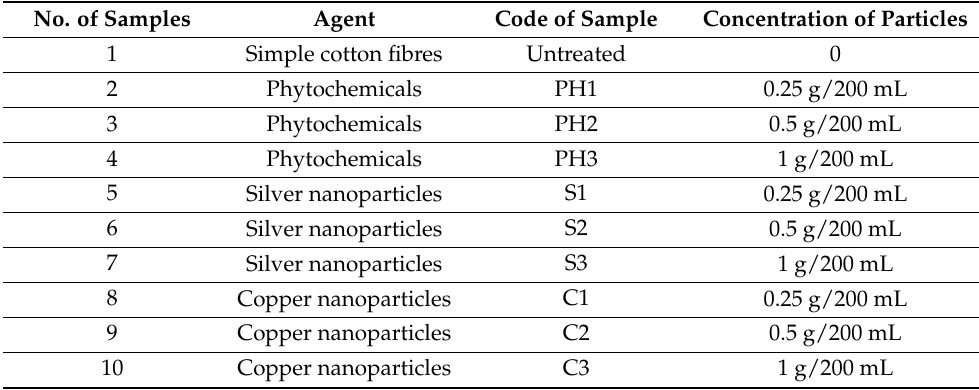
Figure 5. Application of prepared particles and phytochemicals of cotton fabric. Table 1. Design of experiments for the developed